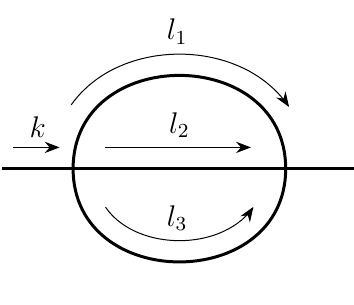
Figure 2 . The underground diagram, the lowest order diagram that contributes to wave-function renormalization in Archimedean (cid:30) 4